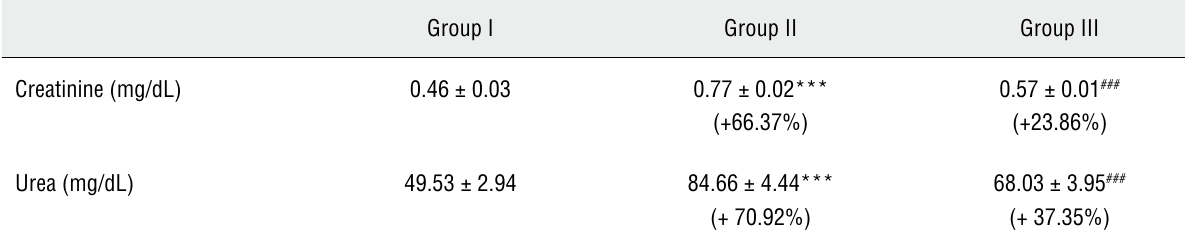
Table 2 - Effect of various treatments on serum creatinine and urea level in experimental rats.